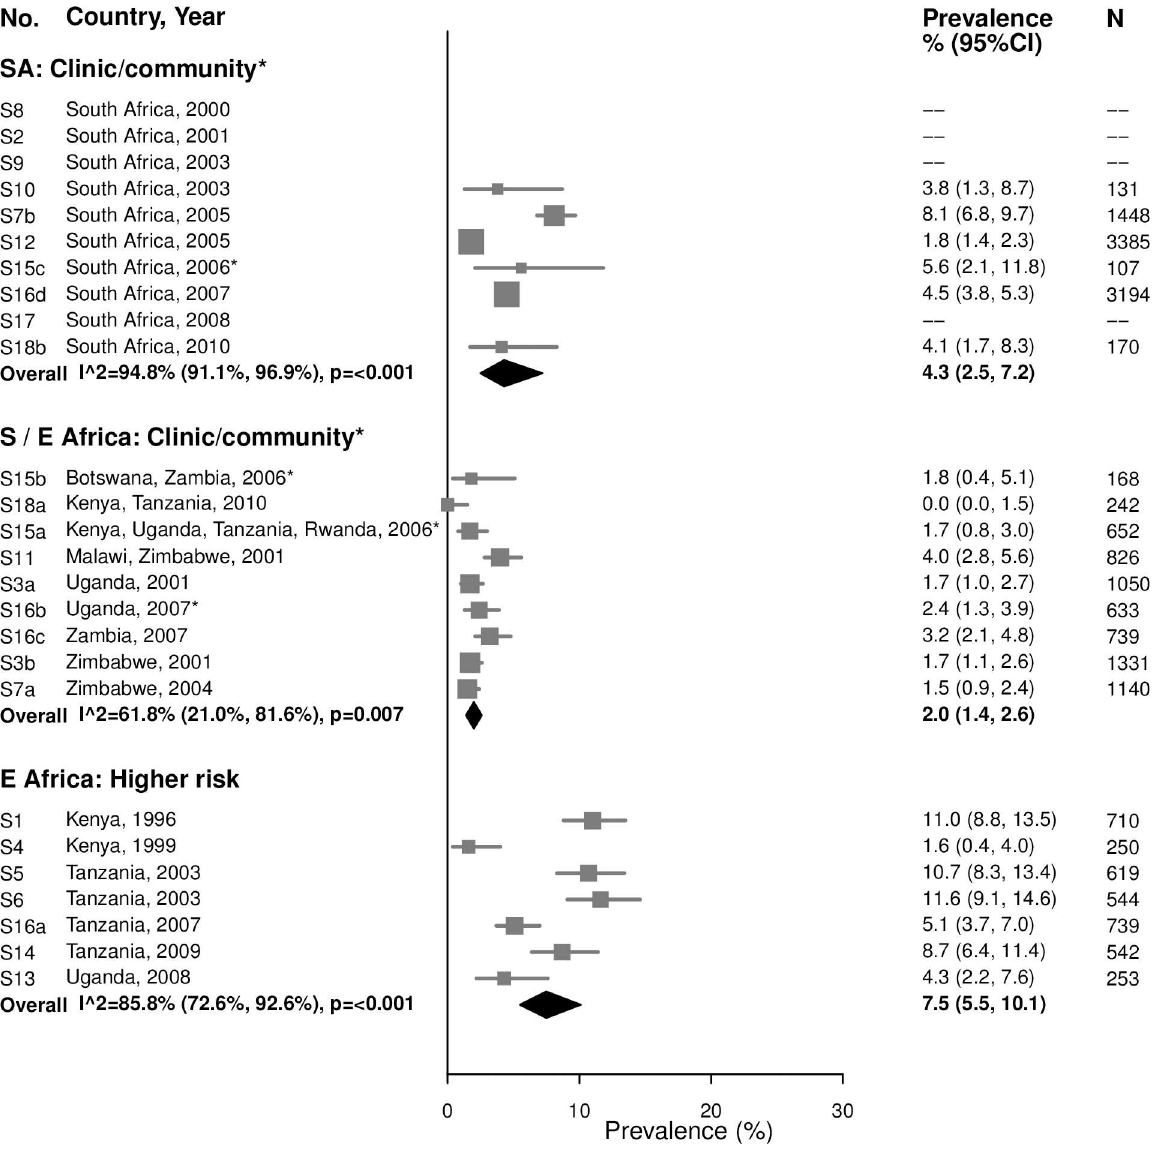
Fig 6. Syphilis overall prevalence among 25–49-year-olds. The area of the marker is proportional to the square root of the sample size. Studies with no estimate presented did not meet the inclusion criteria for this infection and age group. Year presented is the median year that baseline data were collected during the study. (cid:3) Includes studies of HIV-discordant couples. E Africa, Eastern Africa; SA, South Africa; S/E Africa, Southern and Eastern